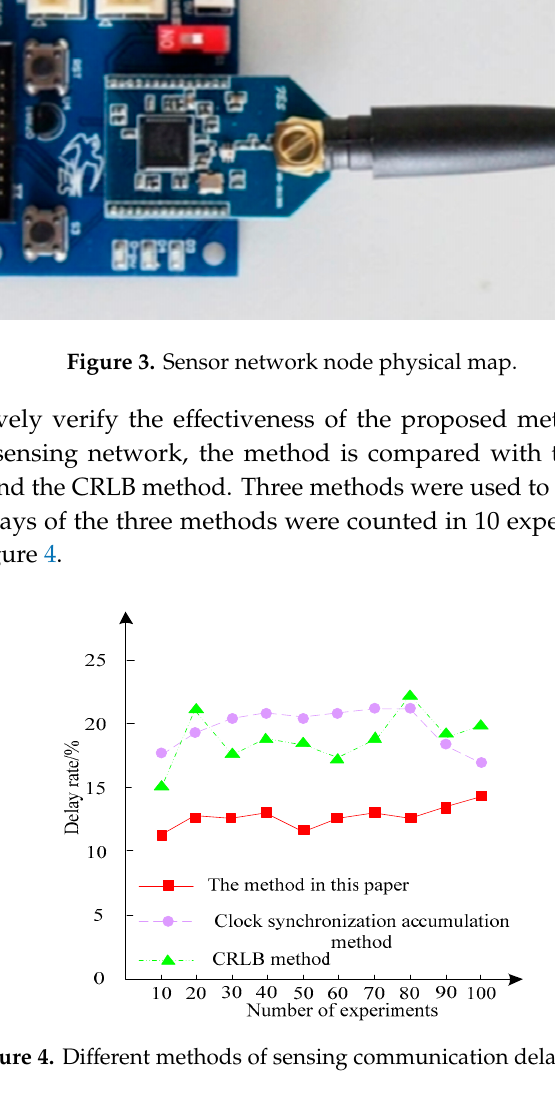
Figure 2. Sensor communication network node distribution map.